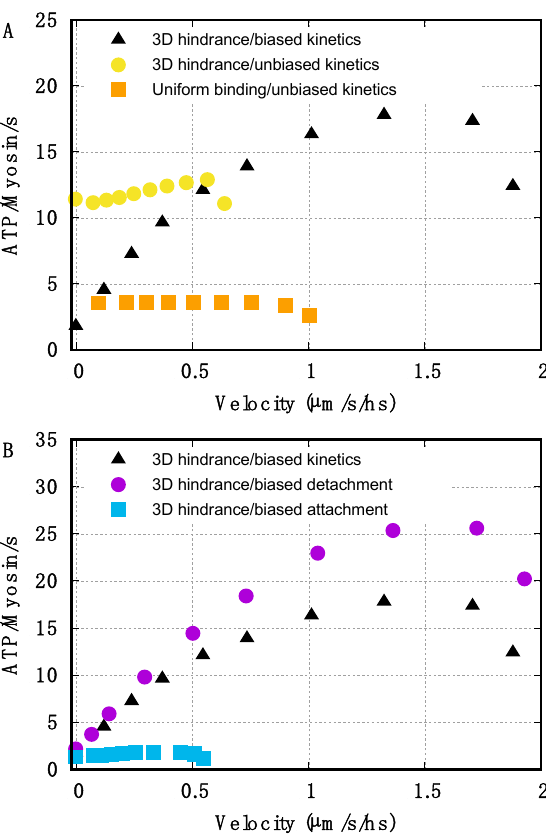
Figure 3. Analysis of the effect of biased kinetics and geometrical hindrance on r ATP ( v ) . Black triangles refer to the model with limited target zones and biased kinetics for comparison. ( A ) Both the limited target zones and the preferential detachment are excluded (orange squares): the ATP-ase rate does not depend on the velocity of shortening except at low external forces (high velocity) due to the mechano-sensing mechanism. When the limited target zone is present without the effect of the preferential detachment (yellow circles), the r max / r iso ratio is lower than the experimental value. ( B ) The geometrical hindrance is included without biased attachment (purple circles) or without biased detachment (blue squares). The high r max / r iso ratio is maintained only when the geometrical hindrance acts together with the preferential detachment of myosin motors. On the contrary, the preferential attachment has no effect on the r ATP ( v )